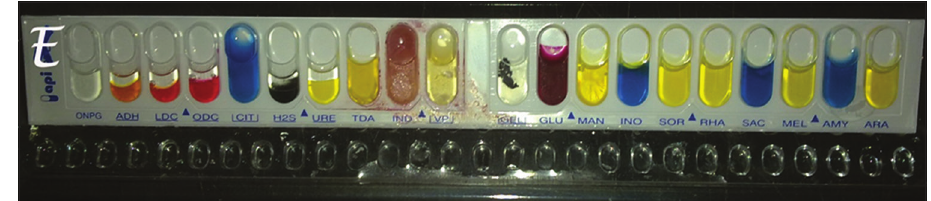
Figure-1: API system for biochemical identification of Salmonella Enteritidis bacterial Table-2: Biochemical identification of SE strain by using API system. Biochemical test